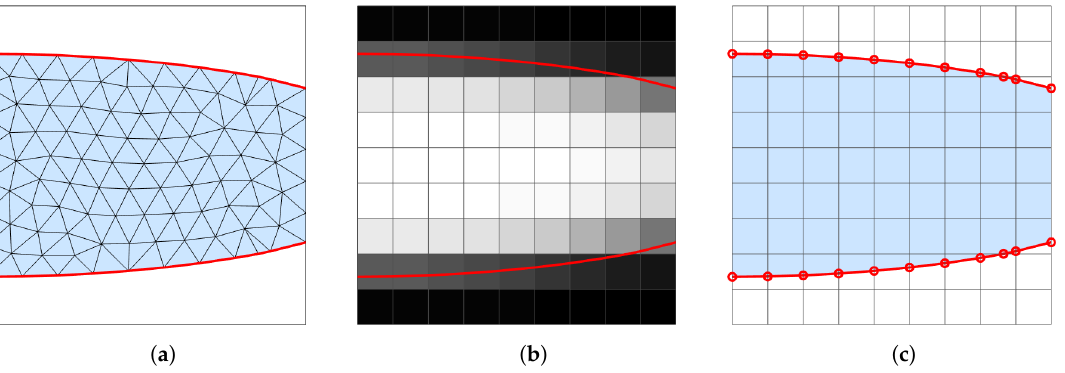
Figure 1. Fluid nozzle illustrating the basic differences among design representations in topology optimisation: ( a ) explicit boundary representation (body fitted mesh); ( b ) density/ersatz material based representation; ( c ) level set based X-FEM/cutFEM